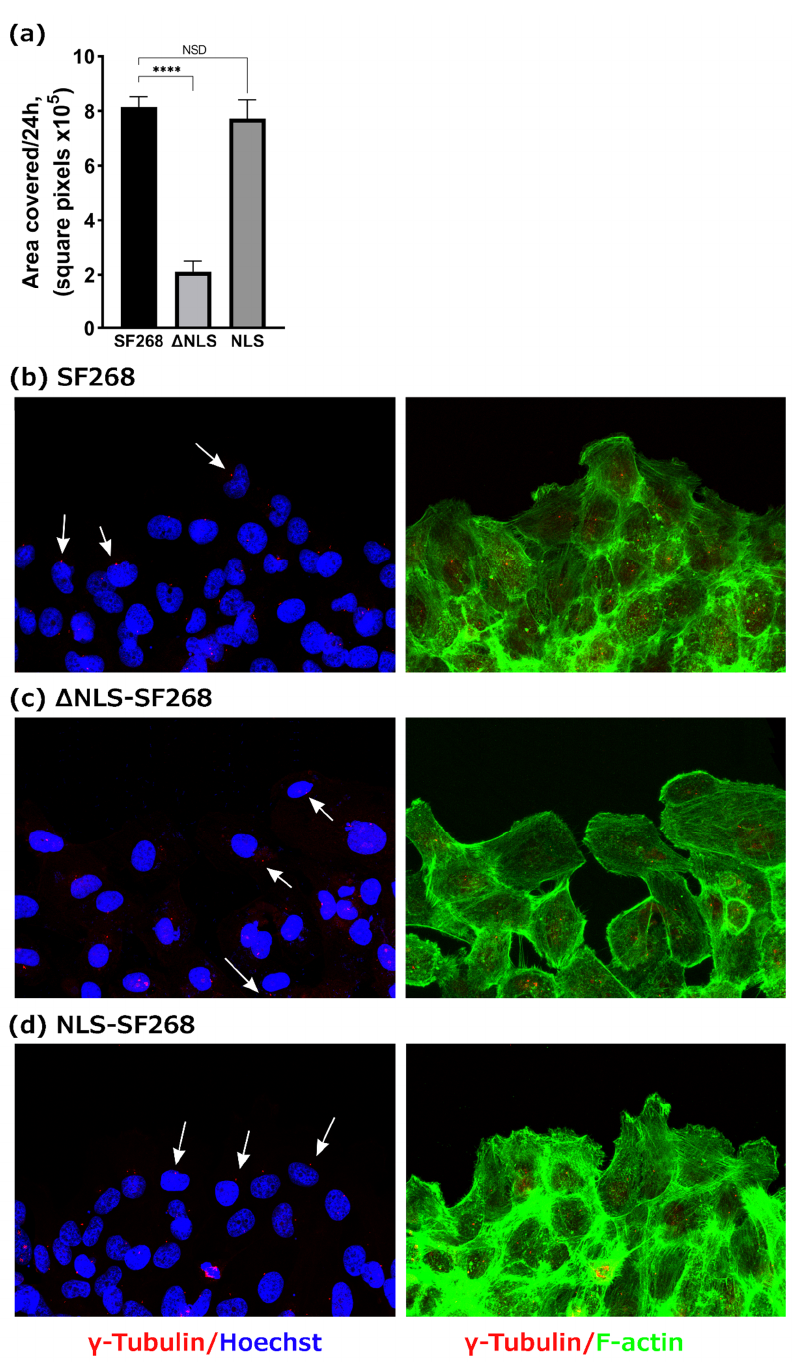
Figure 3. Knockdown of NLS neurofibromin imposes changes in orientation of MTOCs and migration patterns of glioblastoma cells. ( a ) Quantification of the wound healing assay at 24 h. The wound area was calculated by manually tracing in captured images at 0 and 24 h post-scratching and data were analyzed by ANOVA and Tukey post hoc test. Bracketed bars represent the mean and standard error of five di ff erent experiments per cell line; ****, p < 0.0001, NSD, no significant di ff erence. Comparisons of centrosome position (arrows) in fixed (DSP + PFA), immunostained with γ -tubulin, ( b ) parental SF268, ( c ) ∆ NLS-SF268, and ( d ) NLS-SF268 cells revealed misorientiation of both centrosomes and leading edges, relative to the nucleus (chromatin stained with Hoechst) and the long axis of the wound (upper part of panels), with loss of NLS neurofibromins. Images are the maximal intensity projection of confocal serial 0.34 µ m-thick Z-sections with γ -tubulin and Hoechst signals (~10 µ